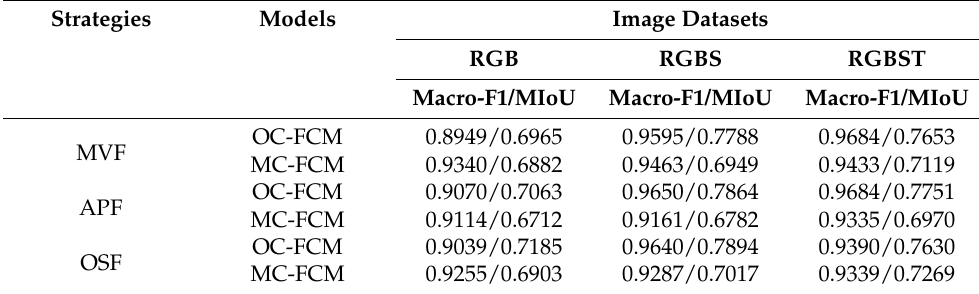
Table 4. Differences in accuracy between OC-FCM and MC-FCM based on different image datasets.